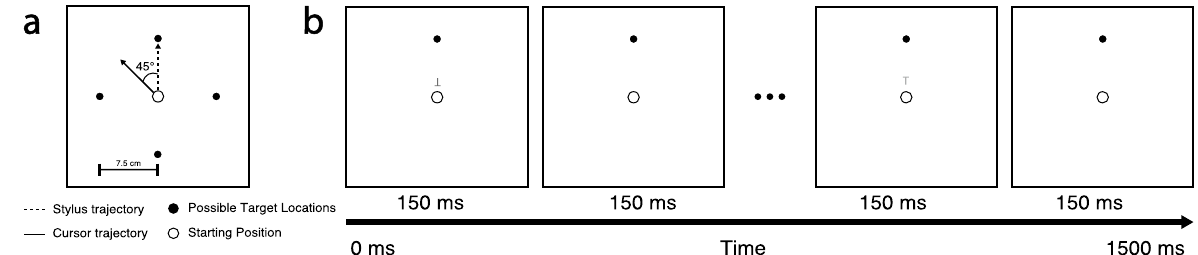
Figure 1. Task schematics. ( a ) Visuomotor adaptation task . The filled circles indicate possible target locations, and the open circle indicates the starting base. Reach targets appeared one at a time and remained visible for the entire trial (1500 ms). In no-rotation trials, the cursor followed stylus motion normally, whereas in rotation trials, the cursor direction was rotated by 45° counter-clockwise from the reach trajectory. The dashed lines show the trajectory of the stylus and of the cursor on rotation trials. There were four phases of visuomotor adaptation: (1) baseline (40 no-rotation trials), (2) learning (160 rotation trials), (3) washout (80 no-rotation trials) and (4) re-learning (80 rotation trials with four target directions). ( b ) Secondary rapid serial visual presentation (RSVP) task. A sequence of five ‘T’s was generated from pseudorandom permutations of letter orientation (inverted or upright) and color (red, white, green, blue or yellow). The sequence was presented serially directly above the starting position, and each letter was displayed for 150 ms with a 150 ms inter- stimulus interval. A target was defined as green ‘T’s. Participants had to report at the end of each trial how many relevant targets (one, two, or three) were presented in that